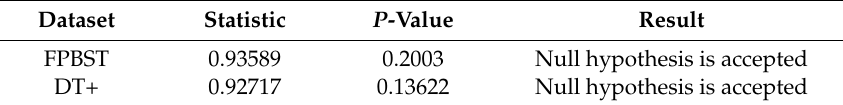
Table 9. Normality test of FPBST and DT+ accuracies obtained from Table 8.